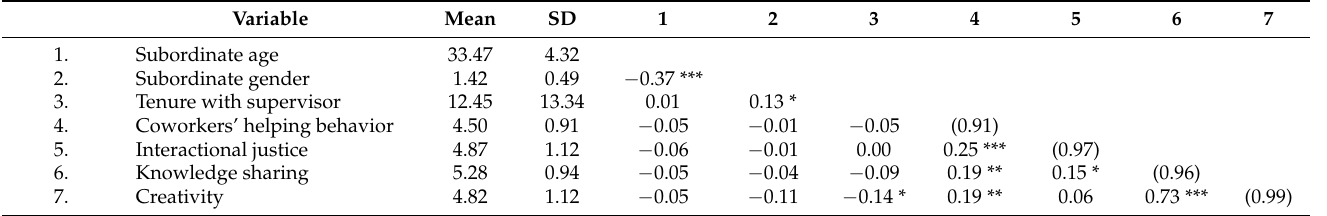
Table 1. Descriptive statistics and